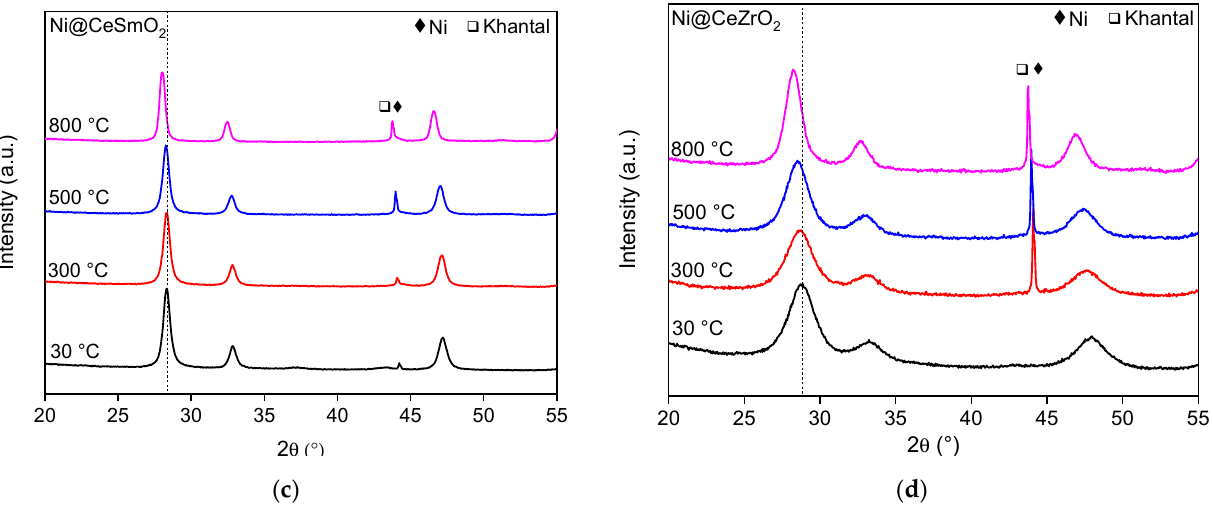
Figure 2. In-situ diffractograms obtained during reduction of ( a ) Ni@CeO 2 , ( b ) Ni@CeGdO 2 , ( c ) Ni@CeSmO 2 and ( d ) Ni@CeZrO 2 .